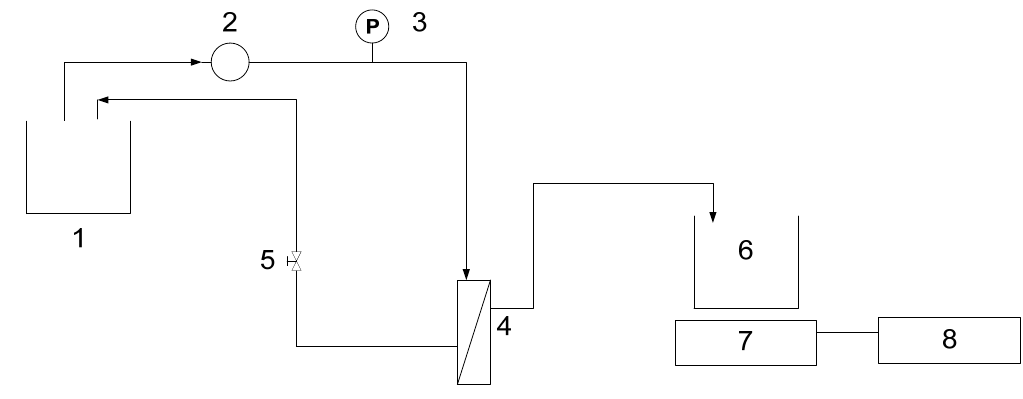
Figure 7. Schematic diagram of the experimental system for membrane